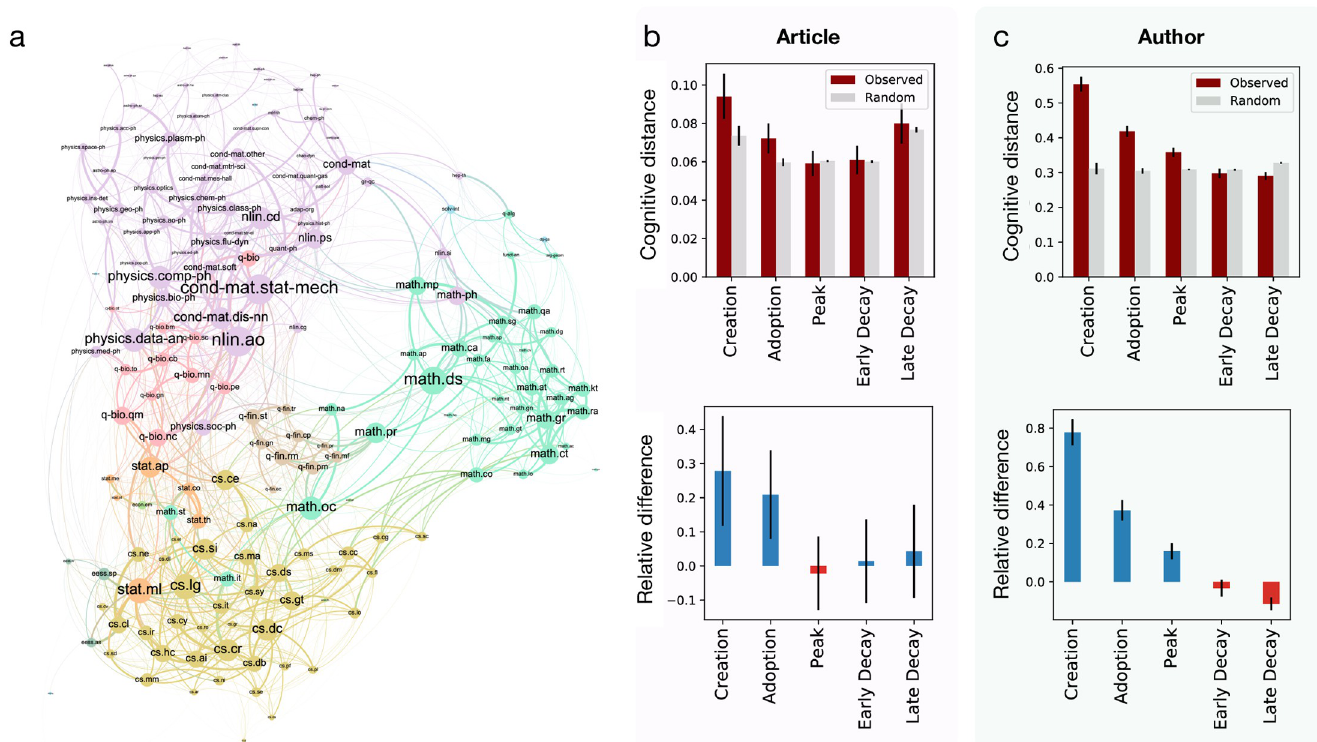
Fig 5. Cognitive distance. a Co-occurrence network of arXiv field tags. Nodes are colored based on the major research area they belong to (Physics, Computer Science, Mathematics, Statistics, Quantitative Finance, Quantitative Biology). Barplots in b,c follow the same method than in Fig 3. b Average cognitive distance across the field tags of articles. c Average cognitive distance across all the field tags used by authors throughout their career.